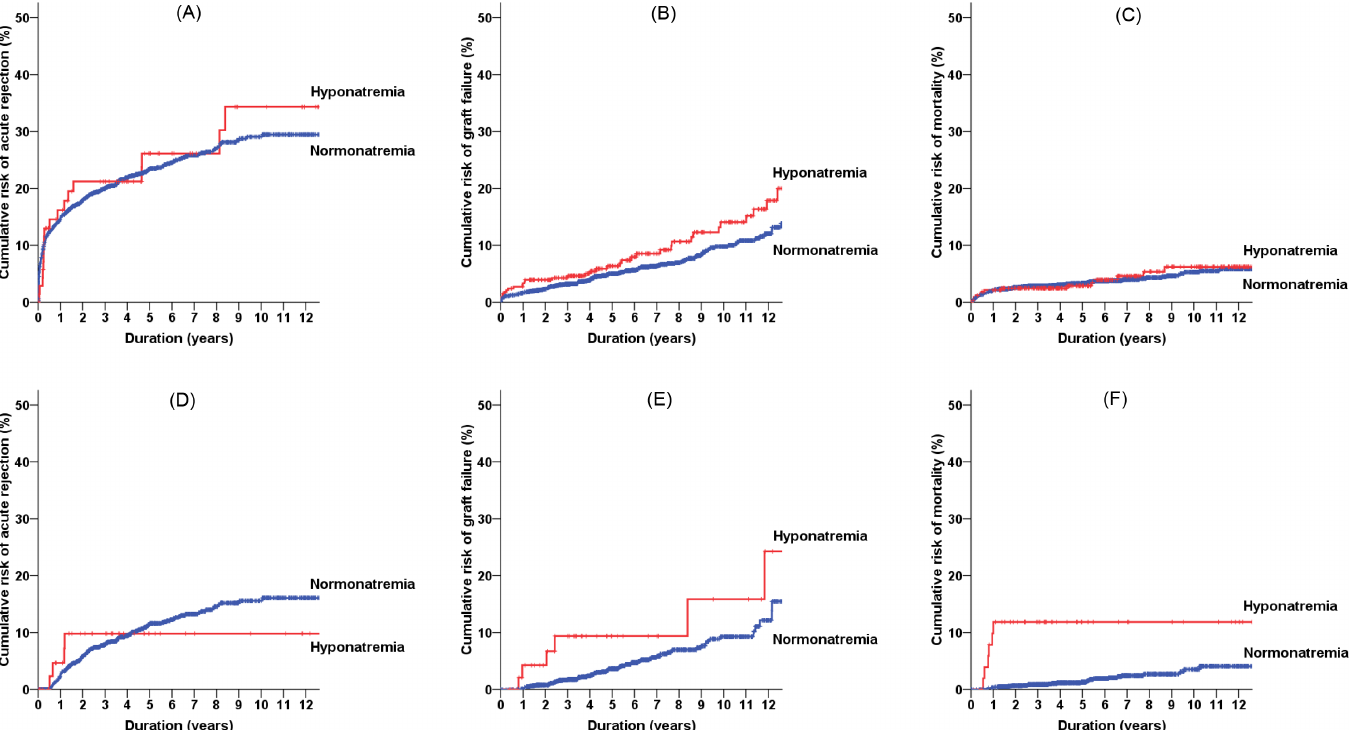
Fig 3. Cumulative risks of acute rejection (A, D), graft failure (B, E), and all-cause mortality (C, F) according to the hyponatremia at baseline (A-C) or 6 months after kidney transplantation